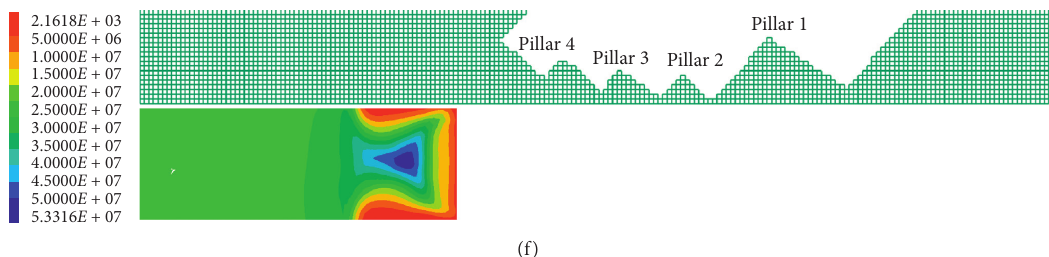
Figure 8: Vertical stress distribution in different mining stages. (a) Before entering the area under pillars. (b) Advancing to the area under pillar 1. (c) Advancing to the area under pillar 2. (d) Advancing to the area under pillar 3. (e) Advancing to the area under pillar 4. (f) After passing through the affected area by pillars.